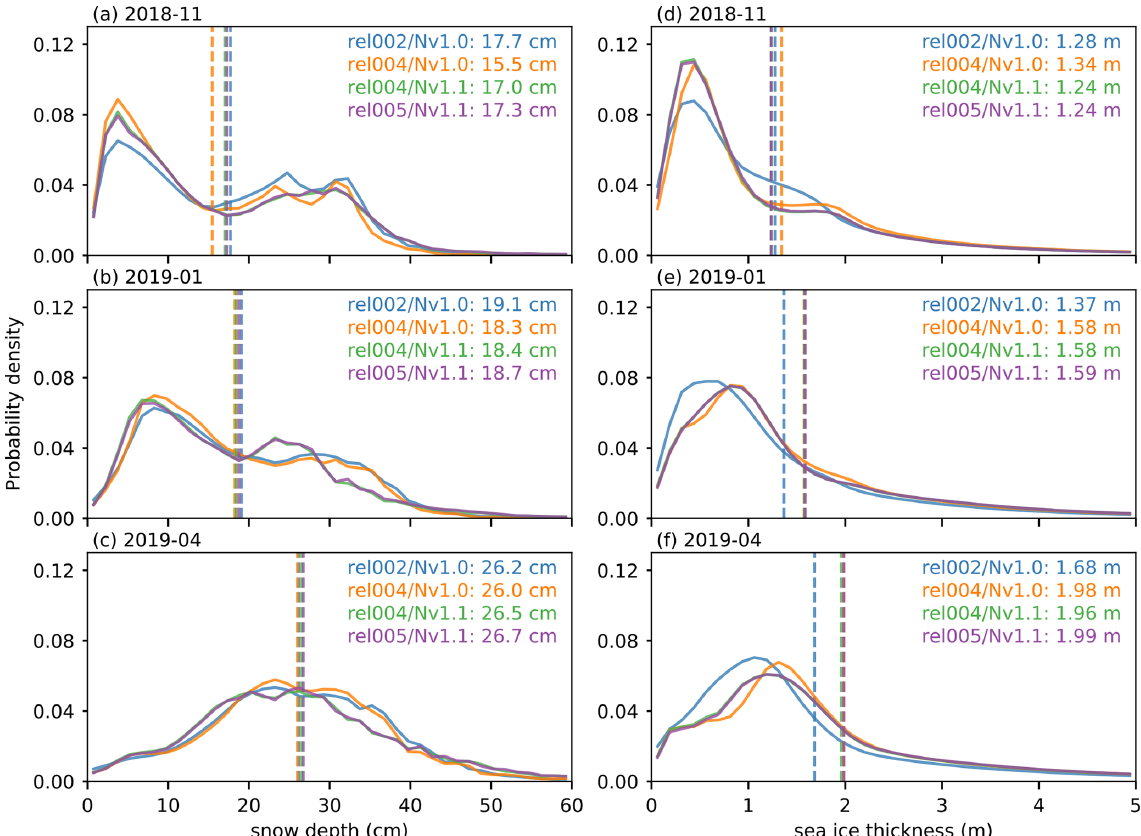
Figure 7. Probability distributions in November 2018 (a,d) , January 2019 (b,e) and April 2019 (c,f) using different combinations of ATL10 release and snow depth/density from NESOSIM v1.0 (Nv1.0) and v1.1 (Nv1.1) of (a–c) redistributed snow depth and (d–f) resultant sea ice thickness. All distributions only show data collected within an Inner Arctic Ocean domain (Fig. 5) using data from beam 1 (strong). Dashed lines show the mean values of each